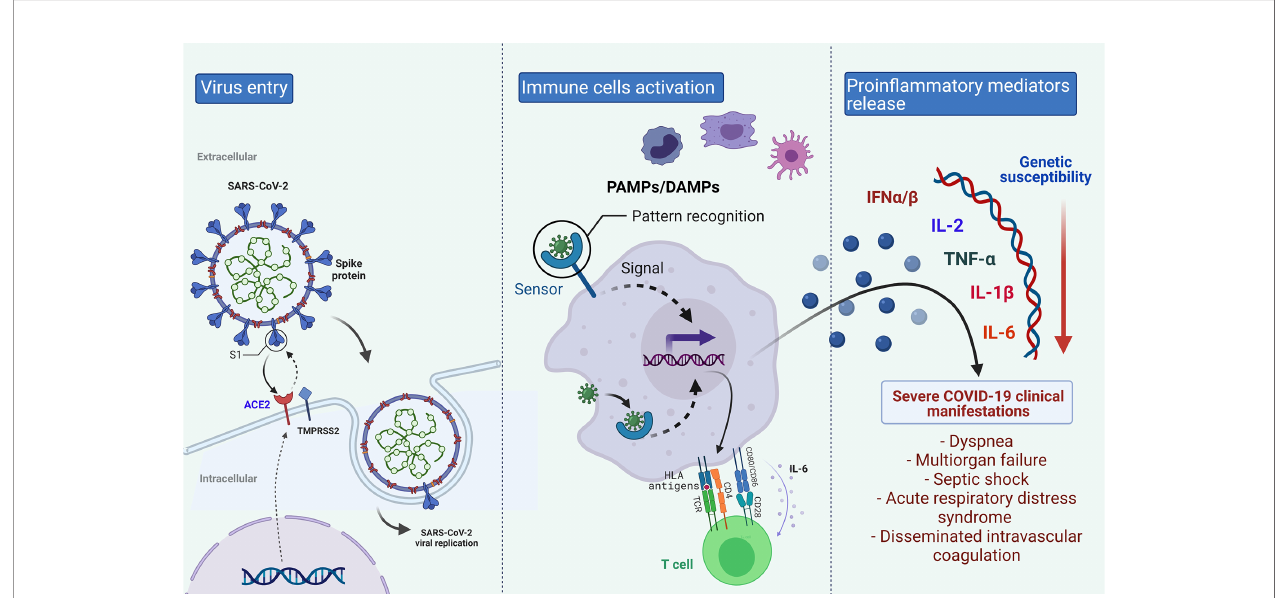
FIGURE 2 | Biological Pathway of COVID-19 in which different genes could be implicated in the disease ’ s differential clinical outcome. Created with